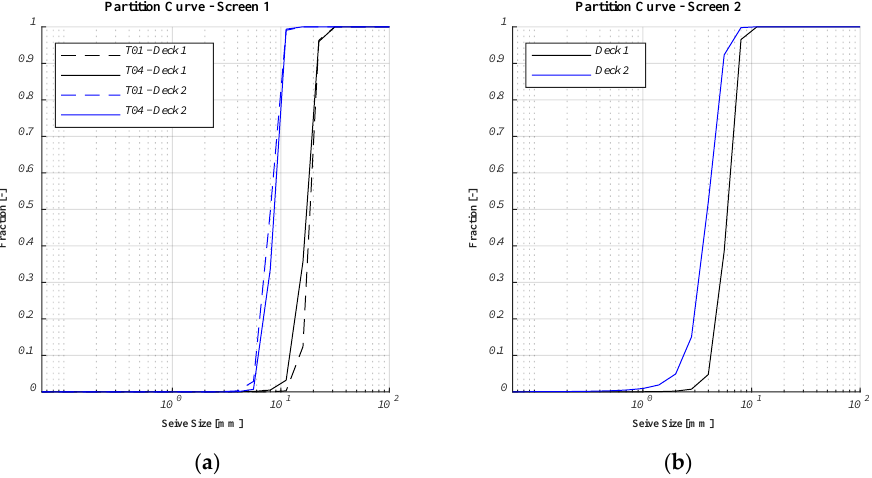
product P2/4 mm consists of a high proportion of undersize and oversize, which is a com-